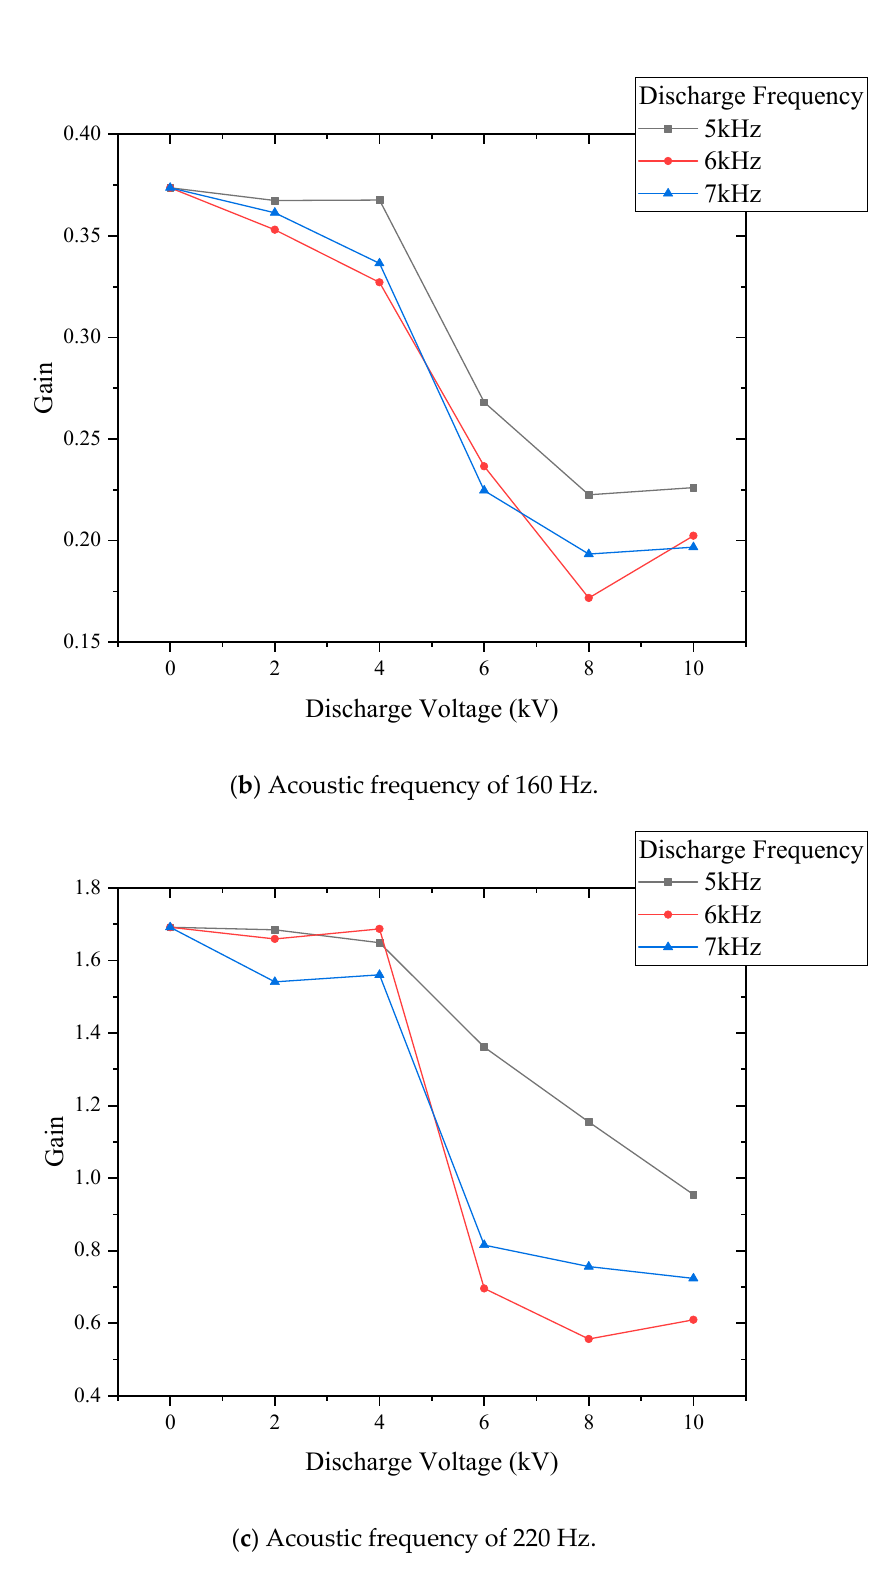
Figure 7. The effects of discharge frequency on the gain in flame transfer function under different discharge voltages.